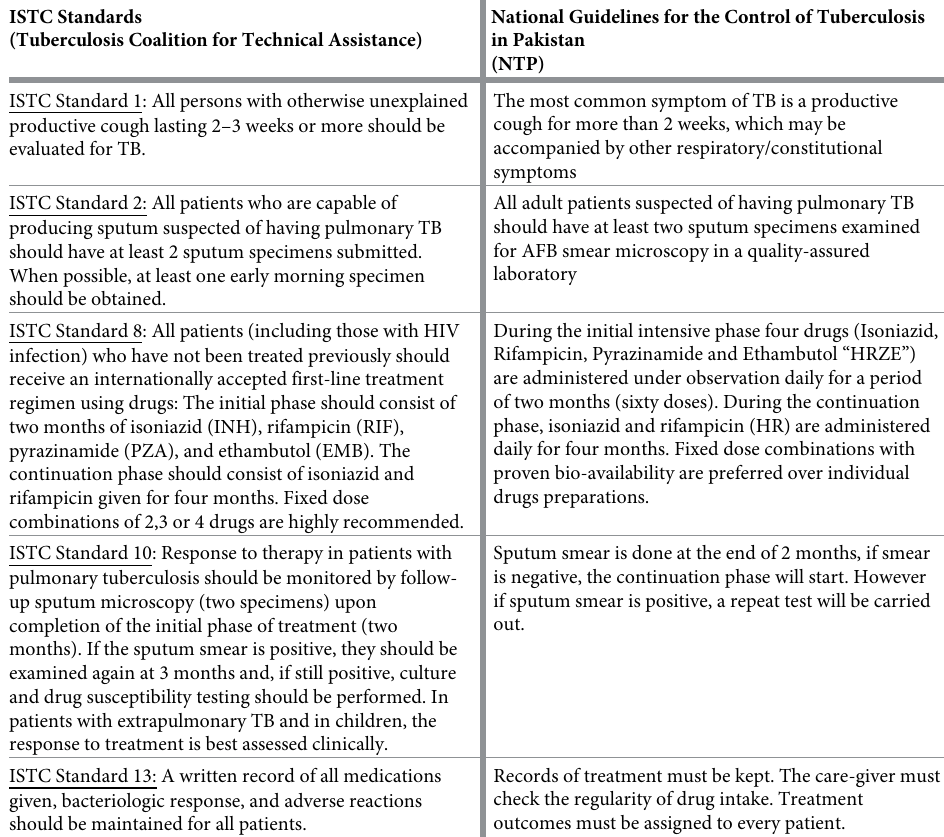
Table 2. National and international guidelines on TB care. ISTC Standards (Tuberculosis Coalition for Technical